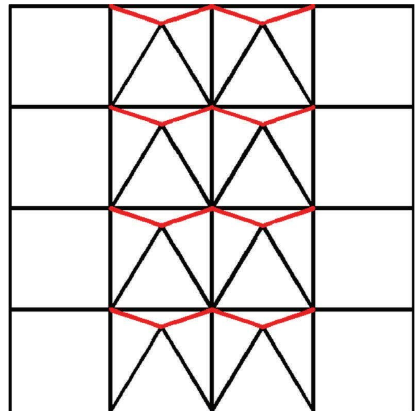
Figure 11: Model